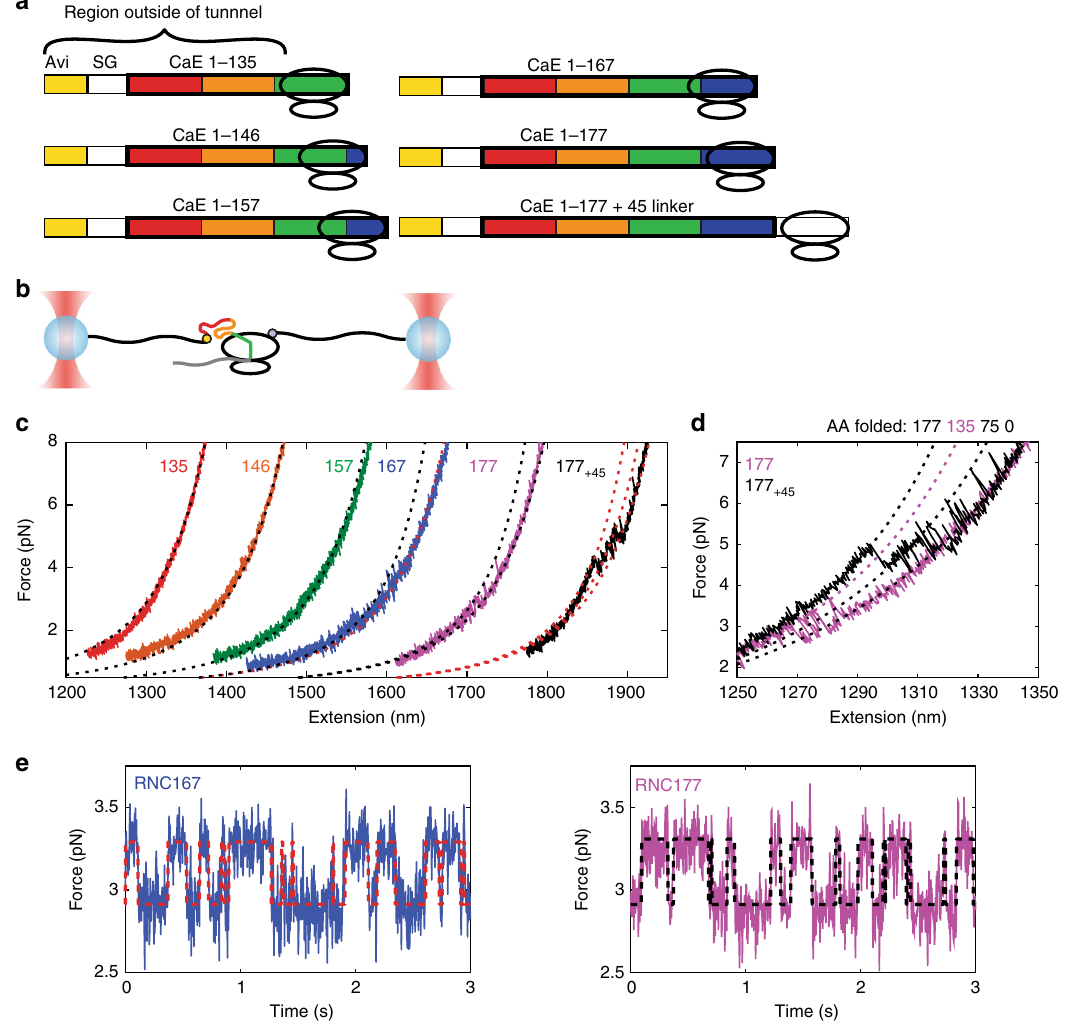
Fig. 2 Stalled RNCs misfold. a The construct design for stalling. Using truncated mRNAs that lack a stop codon, we are able to generate homogeneously stalled ribosomes. The last codon added (in the P site) corresponds to the name of the RNC; less sequence than this will be outside the tunnel. b The OT geometry uses an N-terminal Avi tag and a tag on the ribosome itself. c Refolding force – extension curves of our RNCs do not show any folding until codon 167 or 177. WLC models are shown as dotted black or red lines. The WLC model assumed 40 amino acids in the ribosomal exit tunnel. For RNC167 and RNC177, folded WLCs show a transition of 135 amino acids. For RNC177 + 45 , folded WLCs correspond to a transition of 75 and 177 amino acids. See Supplementary Fig. 3 for further testing. Representative force – extension curves from n = 3, 10, 9, 5, 10, 5 molecules, respectively. d An example of the folding of RNC177 and RNC177 + 45 . RNC177 has a misfolded state larger than the C domain (75 amino acids) but smaller than the FL protein (177 amino acids). RNC177 + 45 folds to the FL state. The dotted lines are WLC models to 177, 135, 75, and 0 amino acids folded (black, magenta, black, black, respectively). e Passive mode data of RNC167 and RNC177 shows folding transitions to state M. HMM fi t shown as dashed lines (red for RNC167 and black for RNC177). Source data are provided as a Source Data fi